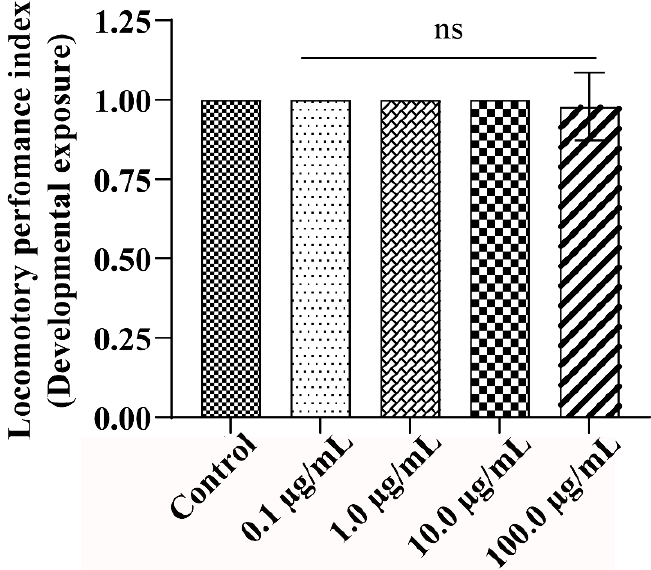
Figure 4. Behavioural assay: Jumping capability of flies eclosed from developmental exposure of larvae fed on control and A.L. extract ‐ treated food. The graph indicates no climbing defect upon exposure to A.L. extract treatment. Significance is as ascribed as ns (non ‐ significant).